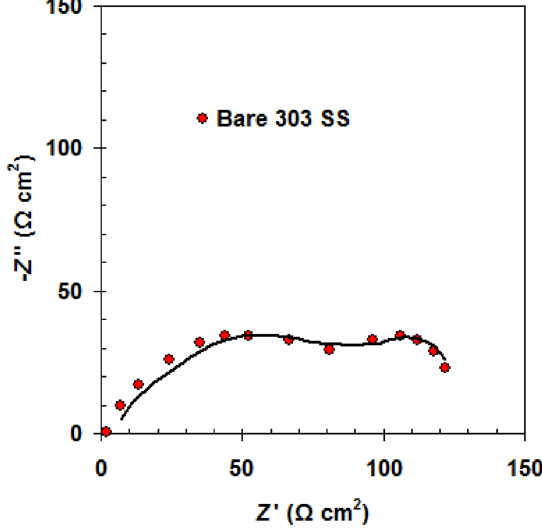
Figure 3. Nyquist plot of bare 303 SS in 1.0 M H 2 SO 4 solution at 298 K.